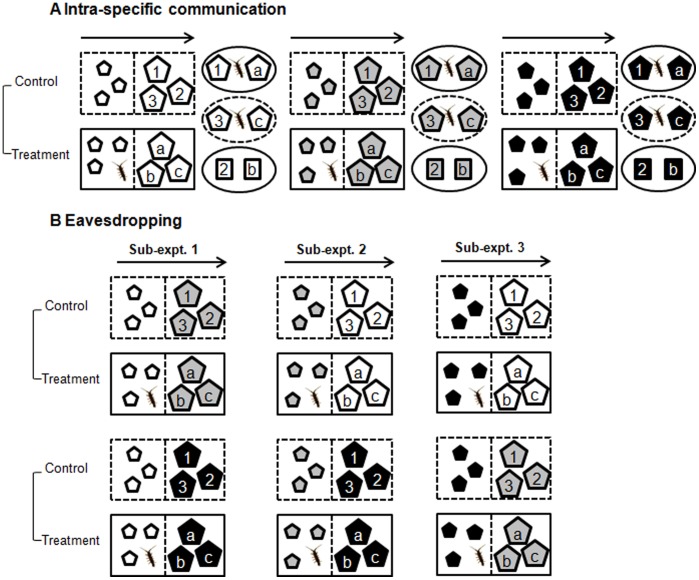
Schematic experimental set-up (displayed for one replicate).Induction of anti-herbivore defences in non-damaged seaweeds was tested in response to water-borne cues from nearby grazed con-specifics (A) and hetero-specifics (B). Aquaria (large rectangles) were supplied by a unidirectional flow of seawater (indicated by arrow) and were divided by a net (dashed line) into upstream and downstream compartments. Small and large pentagons designate seaweed pieces serving as donors and recipients of water-borne cues, respectively. Seaweed species are differentiated by the colours of the pentagons. After 4 d of acclimatisation, grazers were added to treatment aquaria (solid line) and absent in control aquaria (dotted line) during the subsequent 12 d induction phase. Numbers and letters indicate different use of downstream treatment and control seaweed pieces, respectively, in fresh ( = 1 or a) and reconstituted ( = 2 or b) feeding assays, and as autogenic controls ( = 3 or c). Circles with solid and stippled lines illustrate feeding arenas with and without grazers ( = autogenic controls), respectively, in which fresh or reconstituted (quadrates) pieces of seaweed were offered. For clarity, feeding arenas were only shown for intra-specific communication experiments.